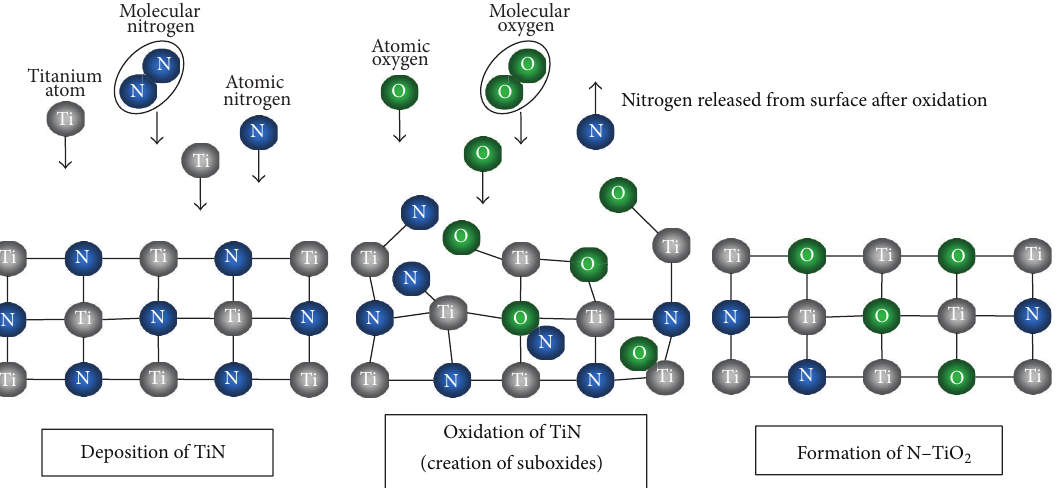
Figure 5: Growth mechanism for nitrogen-doped TiO 2 thin films deposited by DC reactive